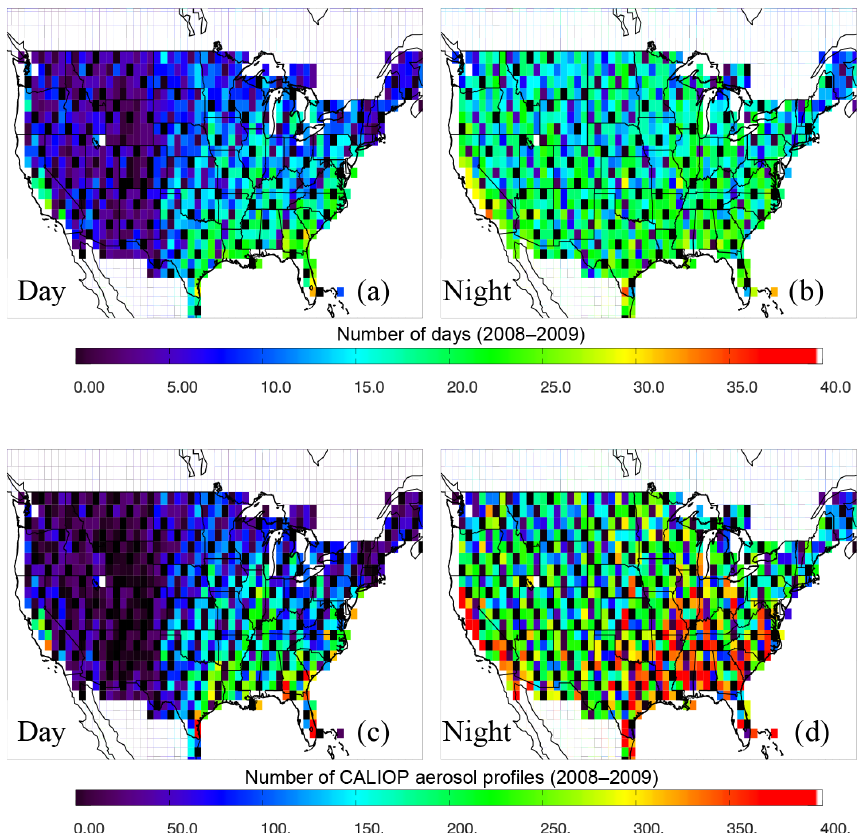
Figure A1. For 2008–2009 over the CONUS, for each 1 ◦ × 1 ◦ grid box, the number of days and CALIOP Level 2 5km aerosol profiles used in the creation of the maps in Fig. 3 for (a, c) daytime and (b, d) nighttime measurements. Values greater than 400 profiles for (c, d) are colored